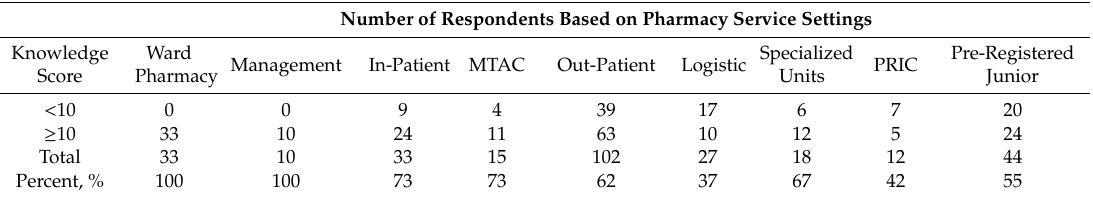
Table 3. Knowledge score breakdown according to the di ff erent pharmacy settings.